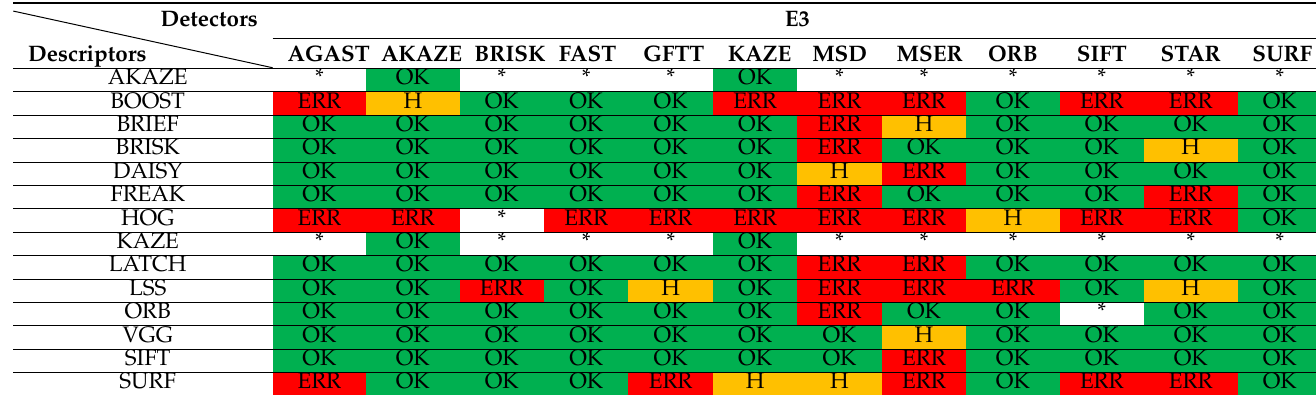
Table A3. The results of matching performed for elevation 3. The description is performed according to Equation (10), and the “*” symbol means descriptor not